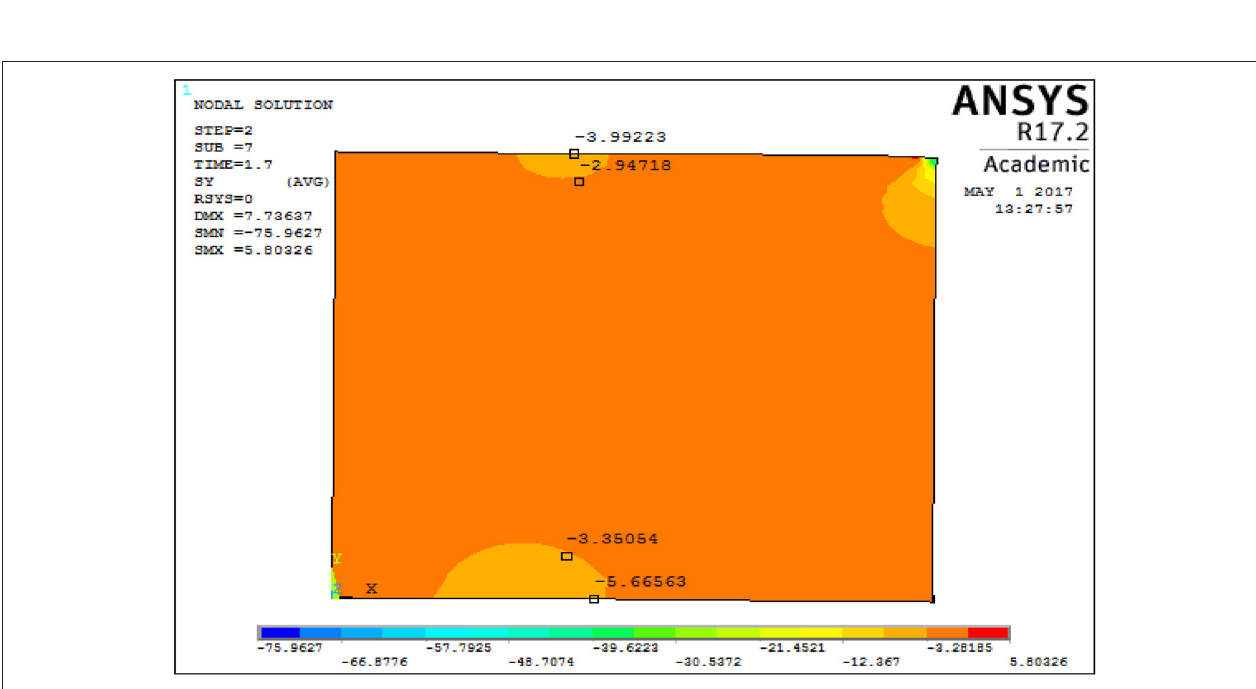
FIGURE 8 | Von Mises stress distribution in the glulam beam for case 1.